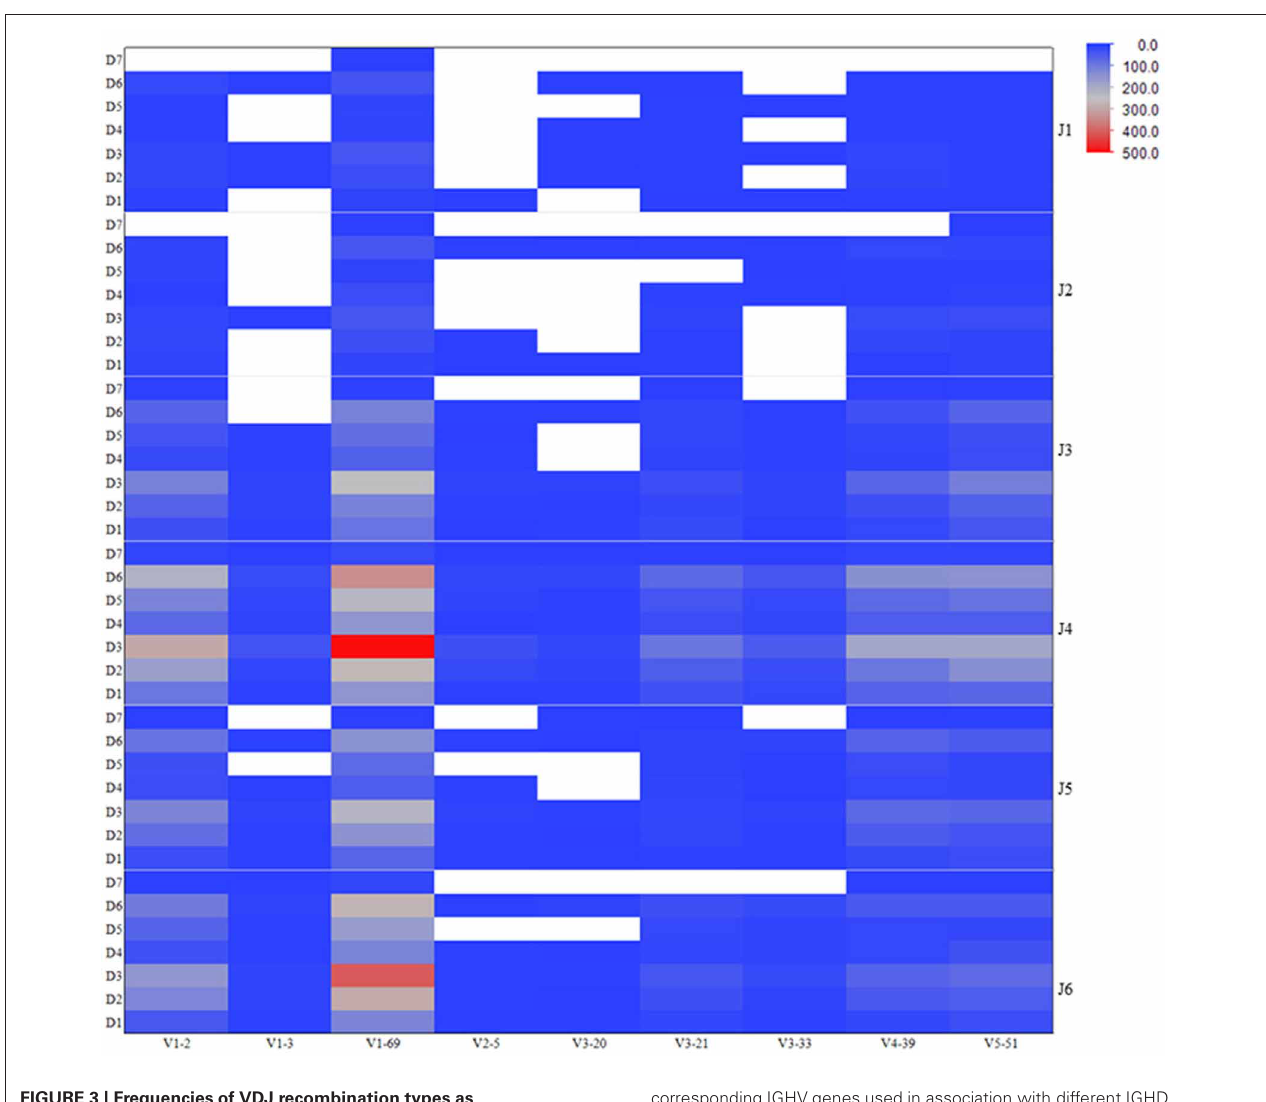
corresponding IGHV genes used in association with different IGHD and IGHJ genes, and is shown on a blue-to-gray-to-red scale. The white-colored space represents the missed or absent VDJ recombination types in the